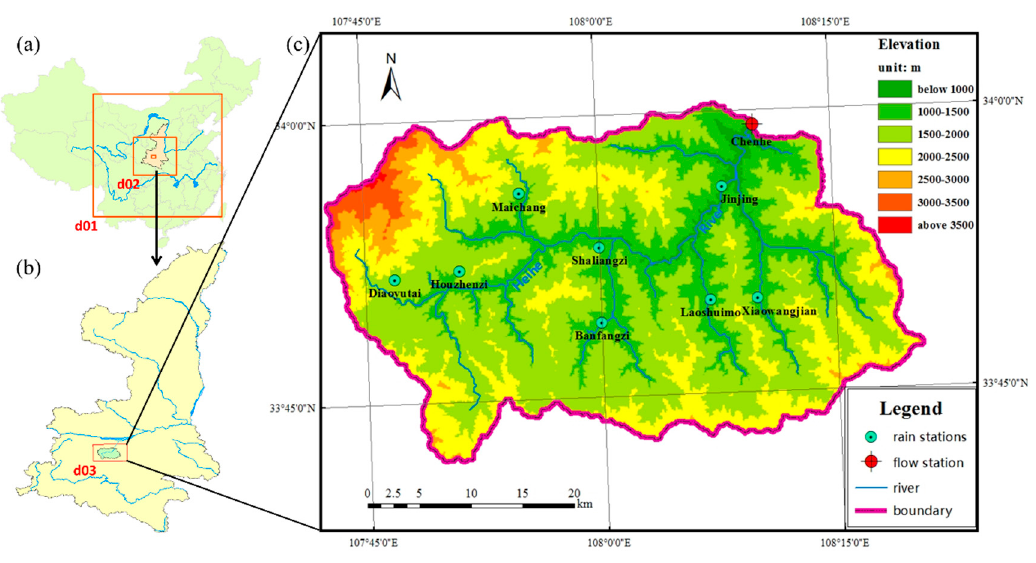
Figure 1. The Chenhe catchment: ( a ) its location and the nested simulation domains 01, 02 and 03 in the Weather Research and Forecasting (WRF) model (more details in Section 2.3), ( b ) the location within Shaanxi Province and the range of domain 03 in the WRF model (in Section 2.3) and ( c ) the channels and rainfall / discharge gauges in the Chenhe catchment.